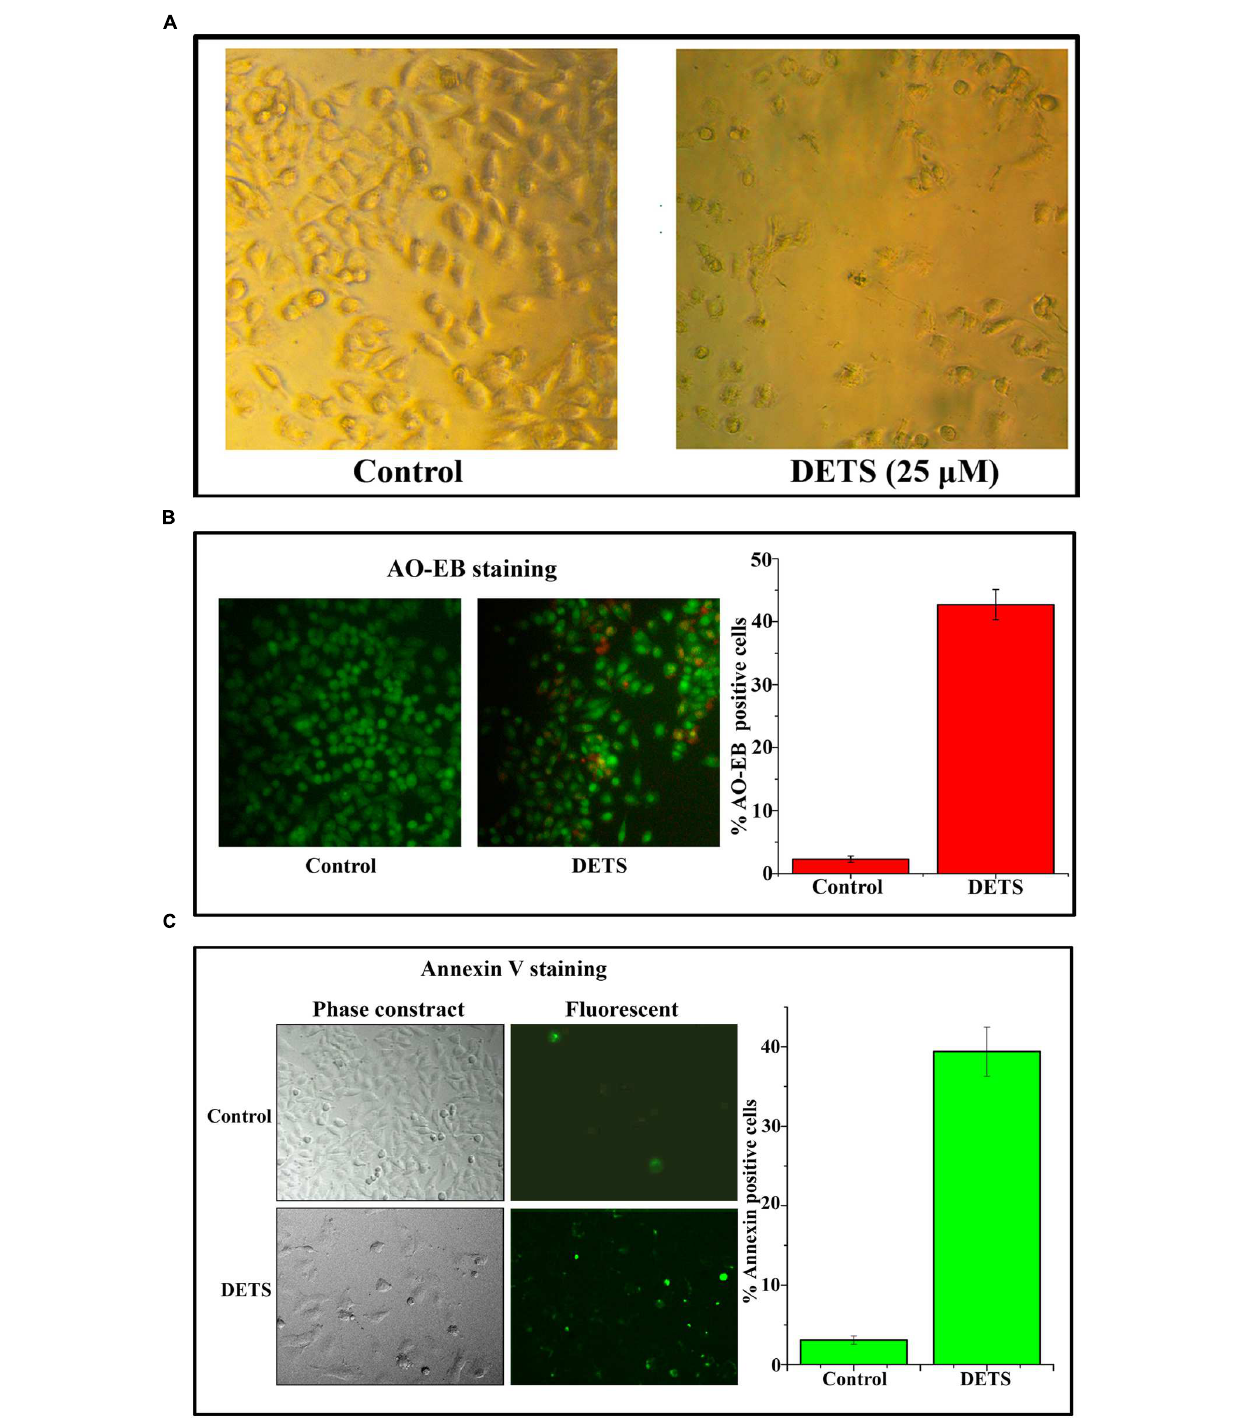
FIGURE 4 | DETS induces morphological changes, membrane damage and membrane flip-flop, characteristics of apoptosis in melanoma cell line, A375. (A) Phase-contrast light microscopy image of A375 cells after 72 h treatment. (B) The early stage and late stage of apoptosis was evaluated by Acridine orange/ethidium bromide staining. AO/EB positive cells were counted in different fields and the average was taken and plotted. (C) A375 cells were treated as indicated with DETS for 24 h and stained for annexin-V positivity and membrane flip-flop was captured by fluorescence microscopy. Annexin-V positive cells in various fields were counted, and the average was taken and plotted. Cells were seeded in 96 well plate, treated with DETS for 24 h and subjected to apoptosis assays. Error bars indicate the standard deviations of 3 measurements. Different letters in the superscript were significantly different according to Duncan’s multiple range test ( p <